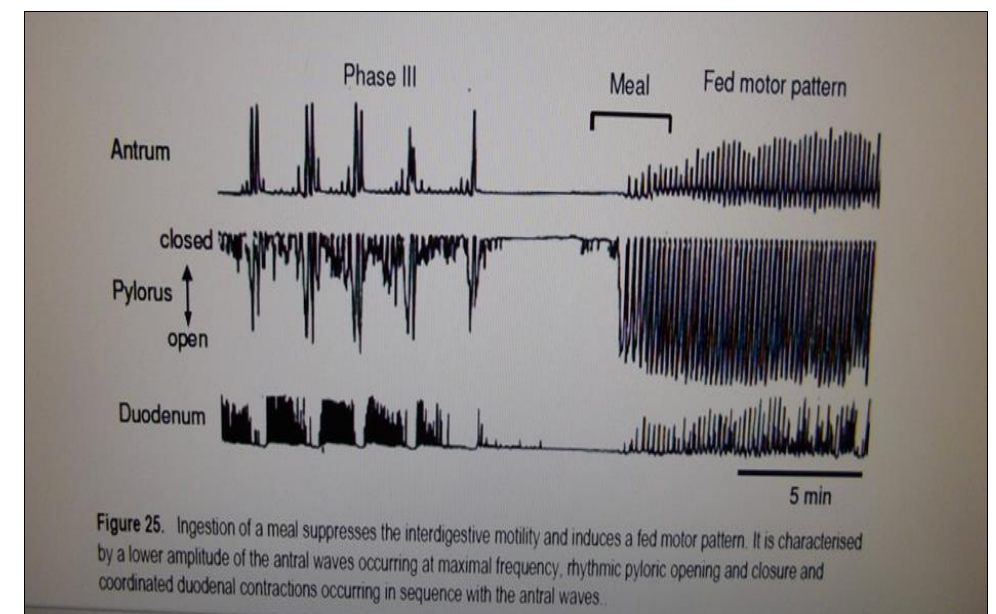
Figure 1: The contractions of the pyloric sphincter are hugely greater in frequency and amplitude after a meal. ( Reproduced from the Tutorial on Gastro-intestinal Motility H.J.Ehrlein and M. Schemann by permission from